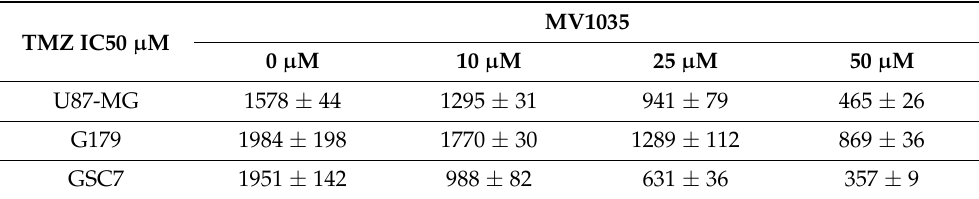
Figure 4. MTT assay of U87-MG ( A ), G179 ( C ) and GSC7 ( E ) cells treated for 24 h with combinations of different concentrations of MV1035 (10, 25 and 50 µ M) and TMZ (75, 150, 300, 600, 1200 µ M). Data are represented as the mean percentage ± SD compared to untreated controls, arbitrarily set to 100%. Synergism analysis between MV1035 and TMZ in U87-MG ( B ), G179 ( D ), and GSC7 ( F ) cells. * p < 0.05, ** p < 0.01 vs. CTRL. Table 1. TMZ IC50 concentrations of different combinations between MV1035 and TMZ against U87-MG, G179, and GSC7